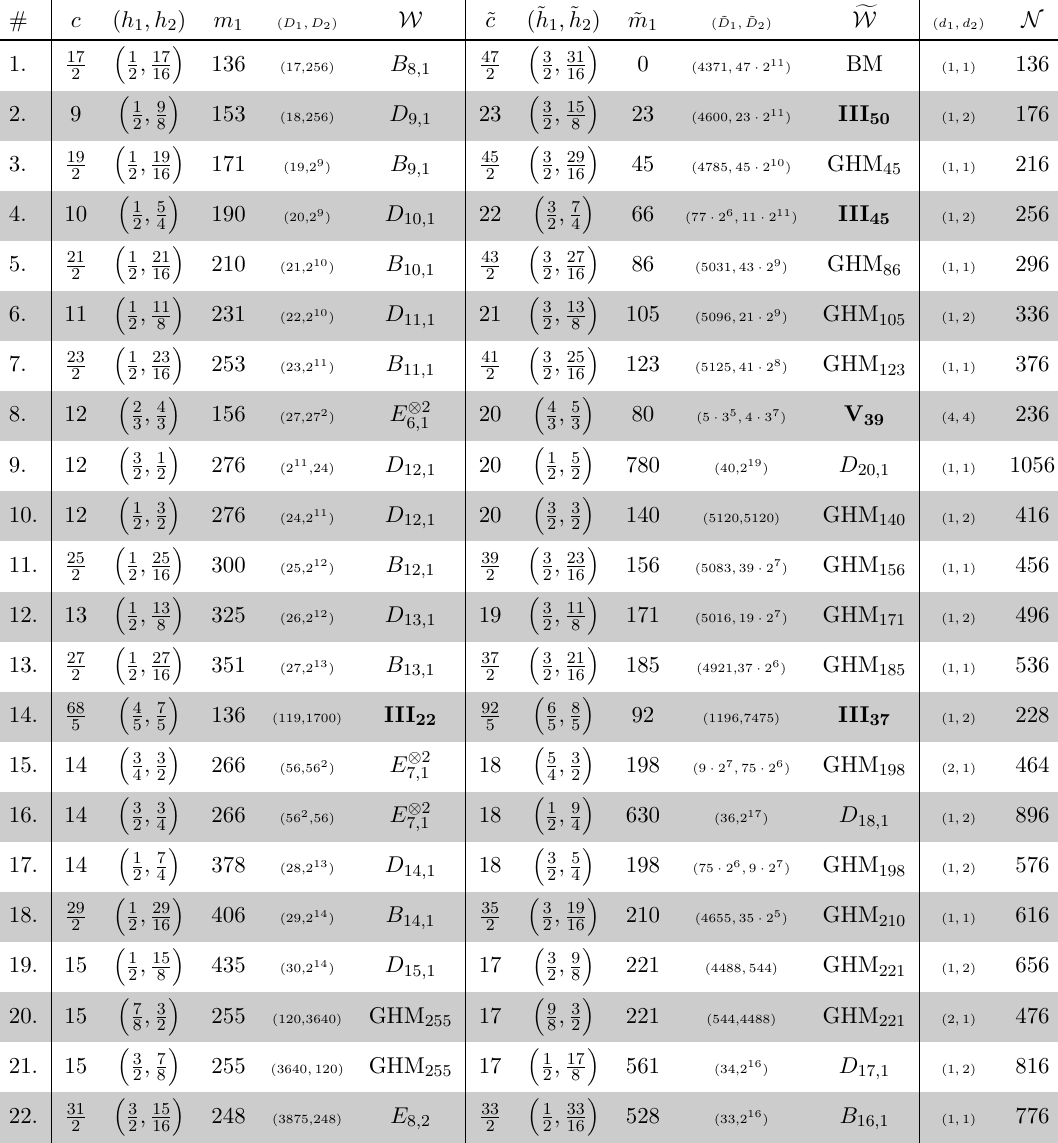
Table 14. CFT pairings, c H = 32 with ( n 1 , n 2 ) = (2 , 3) . The integer N in the last column gives the total number of dimension-1 states in the meromorphic character j 2